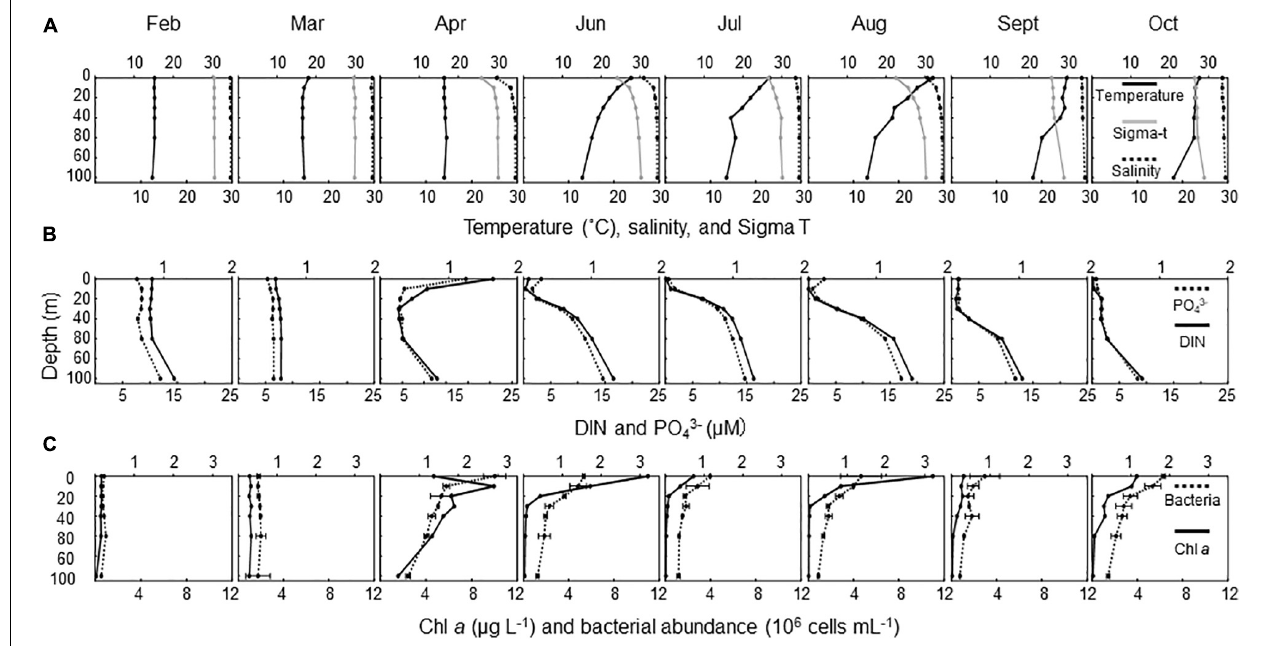
FIGURE 1 | Seasonal changes in vertical distribution of environmental variables. (A) Temperature ( ◦ C, lower x-axis), salinity (upper x-axis), and sigma-t (lower x-axis); (B) dissolved inorganic nitrogen (DIN, µ M, lower x-axis) and PO 43 − ( µ M, upper x-axis); and (C) Chl a ( µ g L − 1 , lower x-axis) and bacterial abundance (10 6 cells mL − 1 , upper x-axis). Errors for bacterial abundance are ranges of estimates obtained using duplicate microscopic slides ( n = 2).